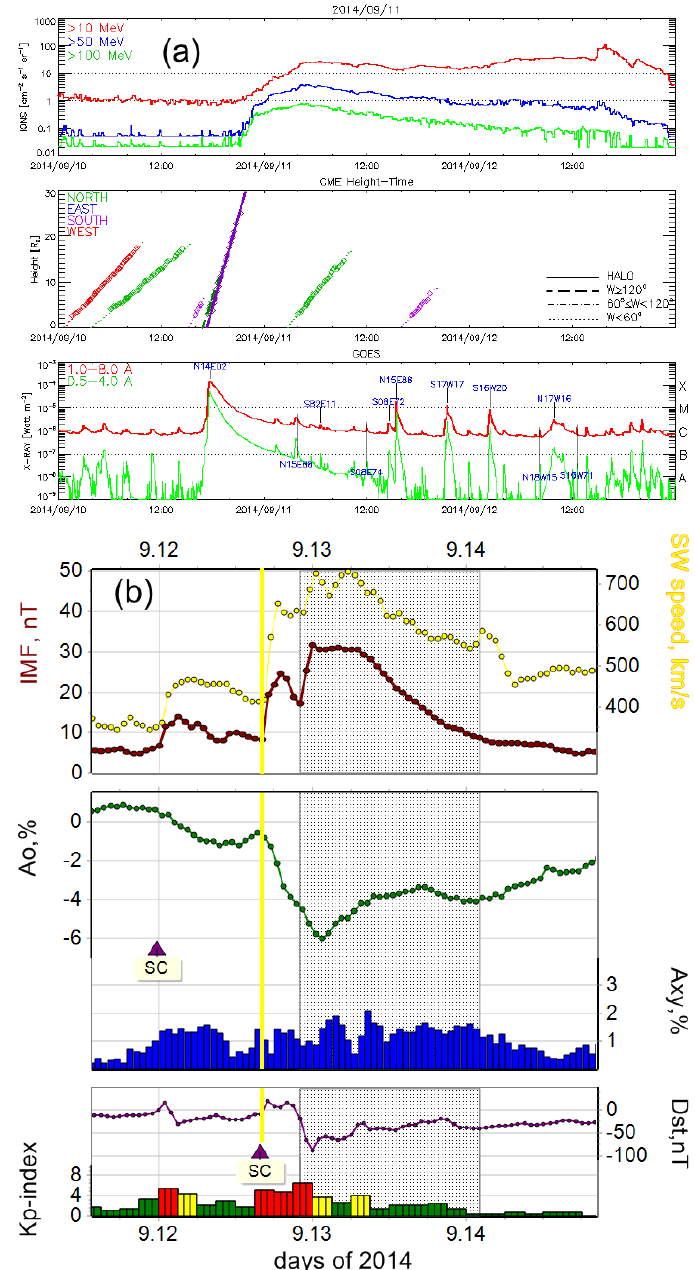
Figure 4. An example of an event from the P 100 group: ( a ) PHTX (taken from SOHO/LASCO CME Catalog); ( b ) behavior of the main SW, IMF, CR, and GA parameters during the FD on 12–14 September